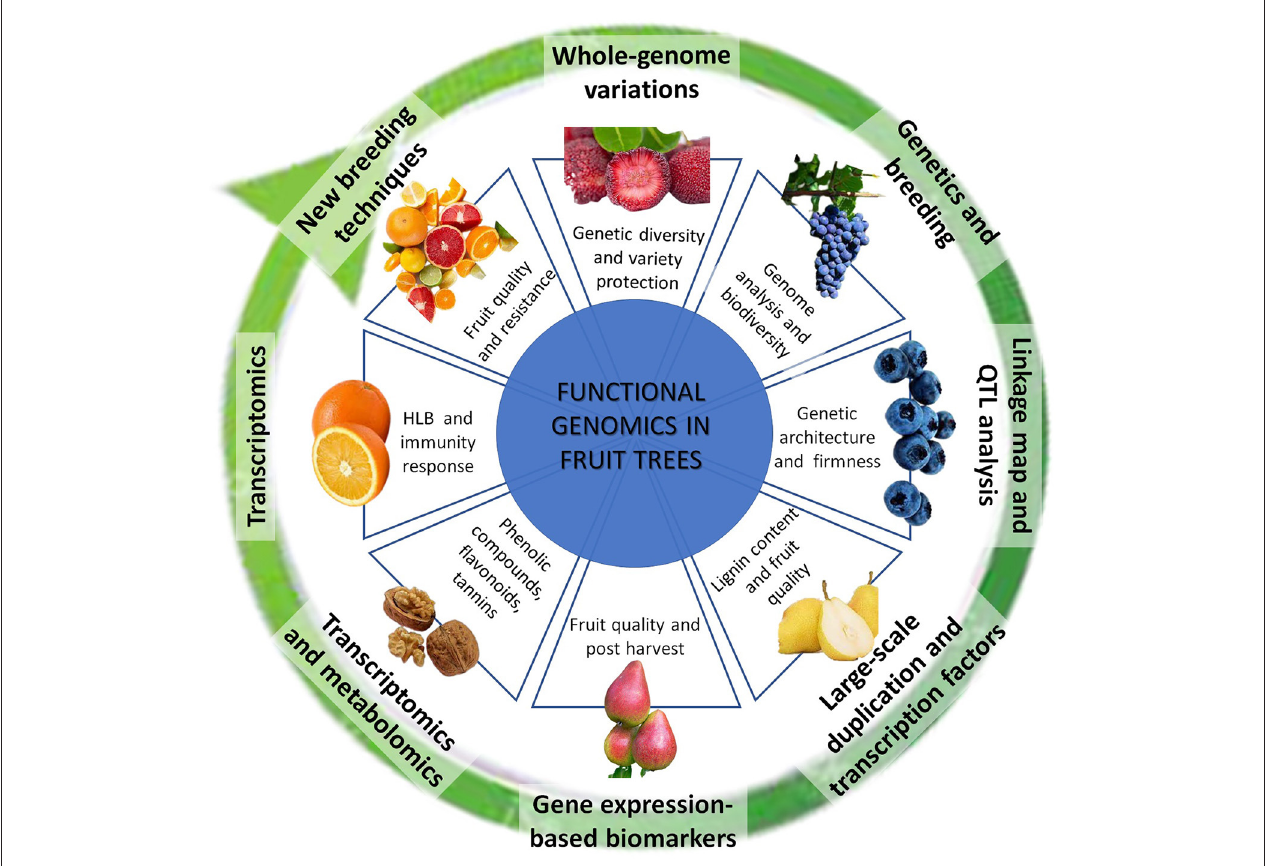
FIGURE 1 | Methods and applications of Functional Genomics in fruits trees. The figure summarizes the main methodologies reported in the manuscripts collected in this Research Topic, represented as a technologically evaluative route that reach the use of new breeding techniques, starting from the knowledge of genome. The plant species and the application scope are punctually